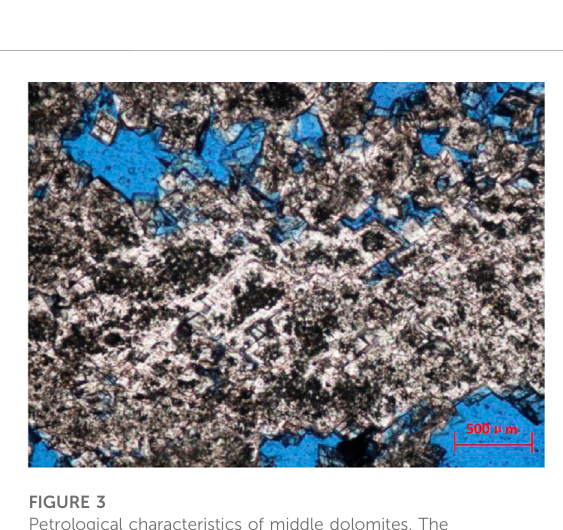
Petrological characteristics of middle dolomites. The powdery residual coral dolomites in the fi rst member of the Meishan Formation (628.86 m) have experienced excessive dolomitization, and the content of “ fog-bright edge ” powdery dolomites is high, with a diagonal length of 1.6 mm